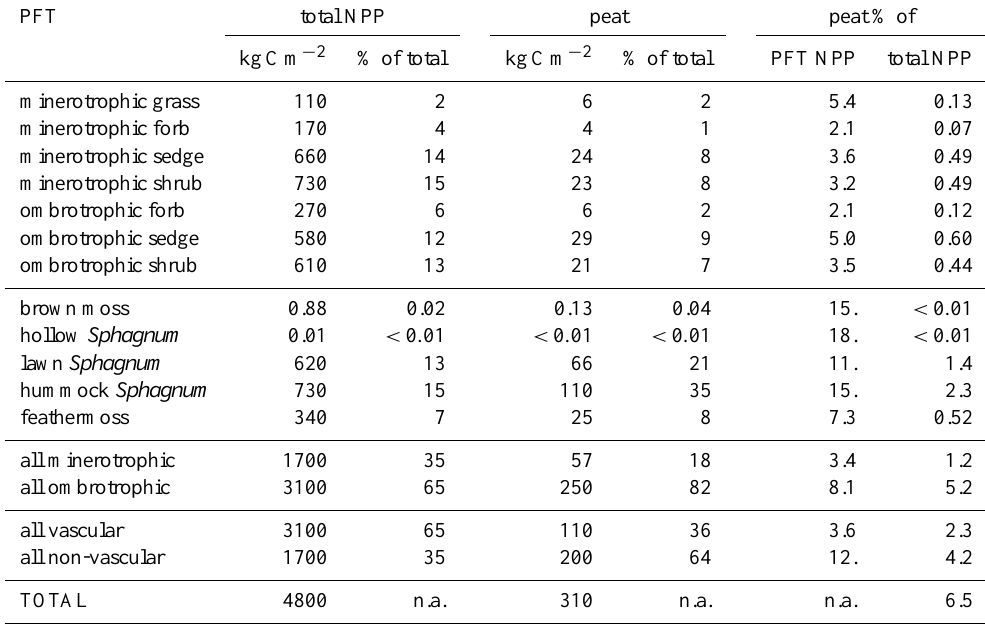
Table 4. Total NPP over 8500-year simulation and final peat-core carbon content by PFT, and by PFTs aggregated by trophic state and major plant form. All values are averages of 4 simulations (see Figs.